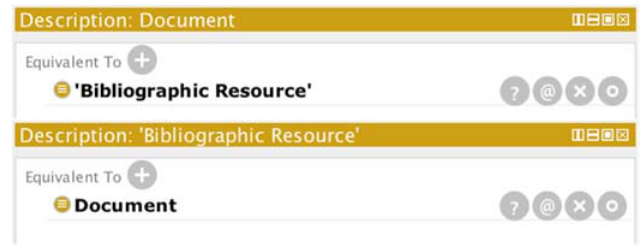
Figure 4. Declaration of “Document” and “BibliographicResource” equivalence.